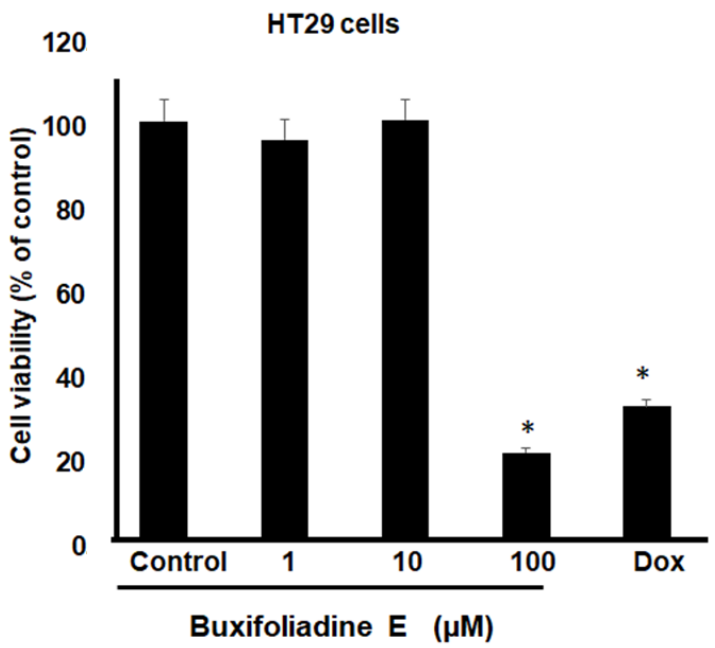
Figure 6. Effect of buxifoliadine E on HT29 cancer cell death. * p < 0.05.